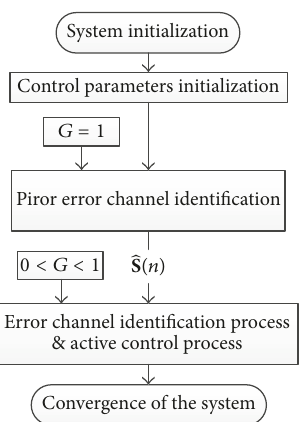
Figure 15: Flow chart of the